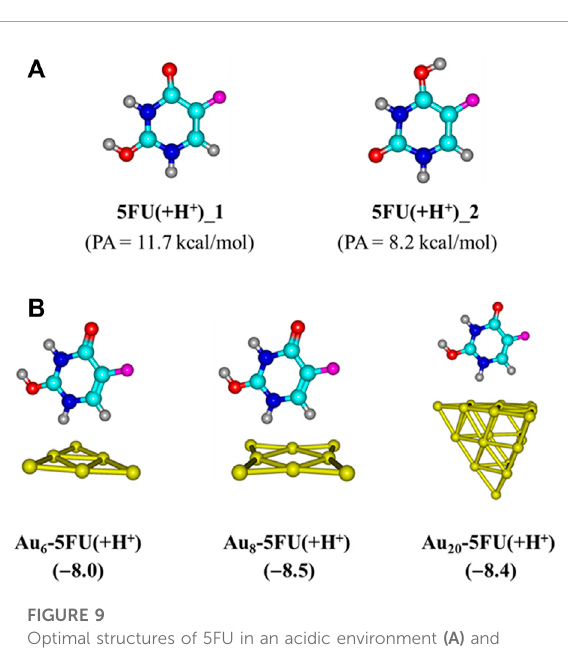
FIGURE 9 Optimal structures of 5FU in an acidic environment (A) and their complexes with gold clusters (B) . Values given inparentheses are binding energies (kcal/mol, PBE-D3/cc-pVTZ/pVDZ-PP +